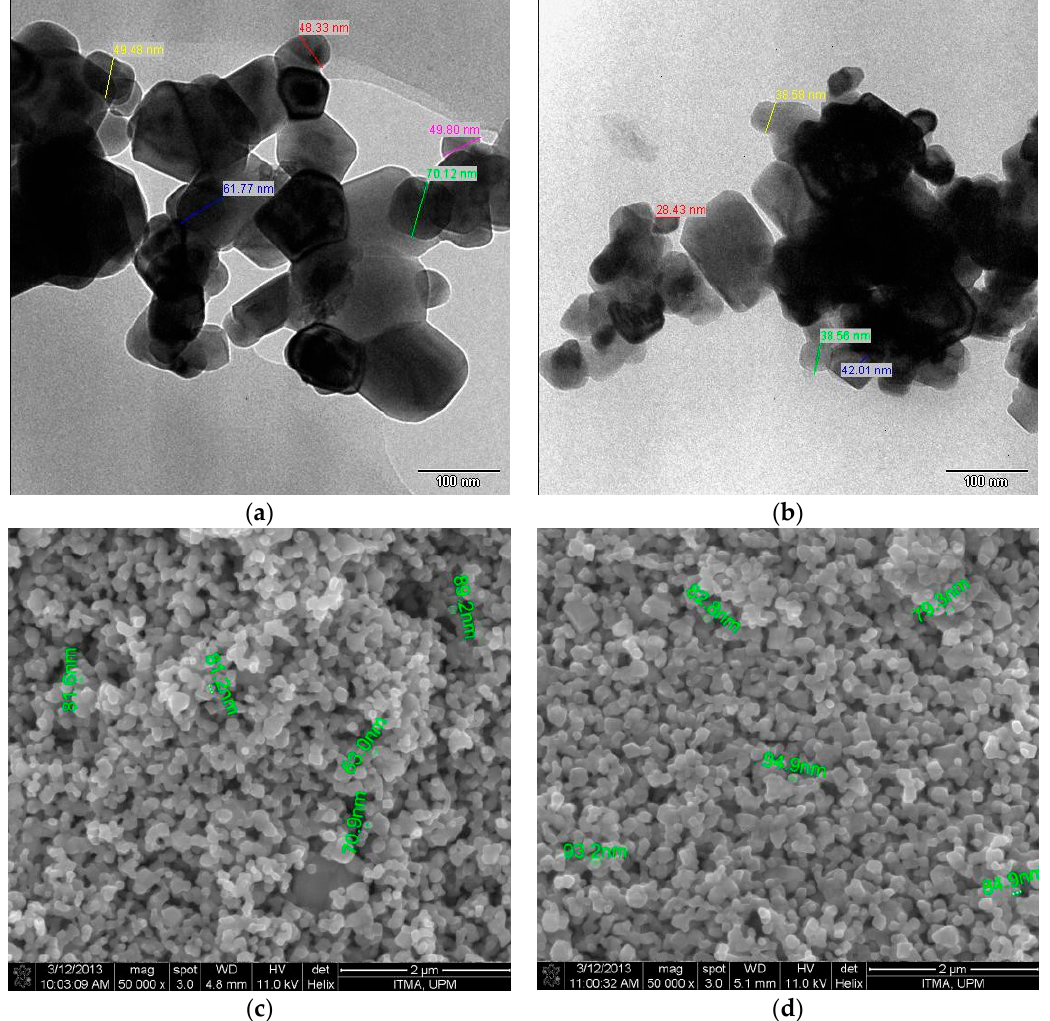
Figure 1. TEM images of nanocomposites calcined at 1000 °C: ( a ) BST; ( b ) 3 mol % MgO doped BST.